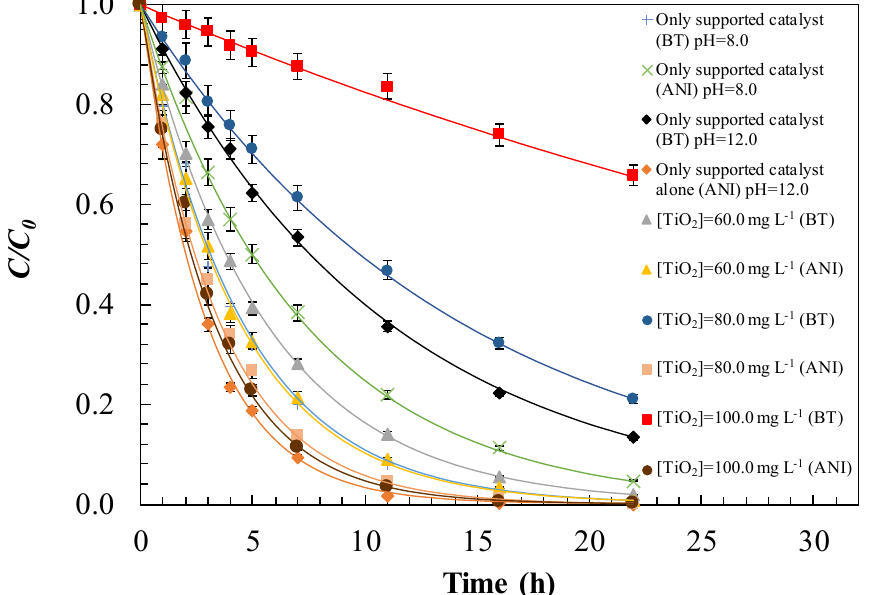
Figure 11. Effect of the matrix on photocatalytic oxidation of aniline and benzothiazole using the supported or supported configuration with addition of TiO 2 in suspension fitted to the pseudo-first order kinetic model ( ——— ). Experimental conditions: C 0 = 22.0 mg L − 1 ; T = 25.0 ◦ C; P = 1.0